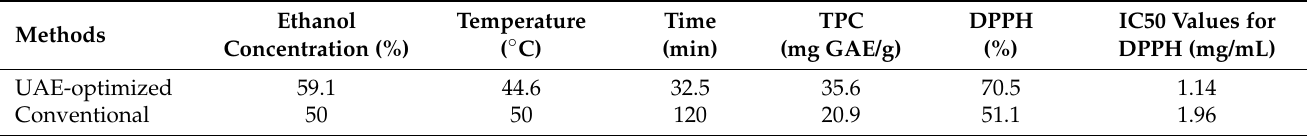
Table 5. Comparison in extraction conditions, TPC and DPPH of each